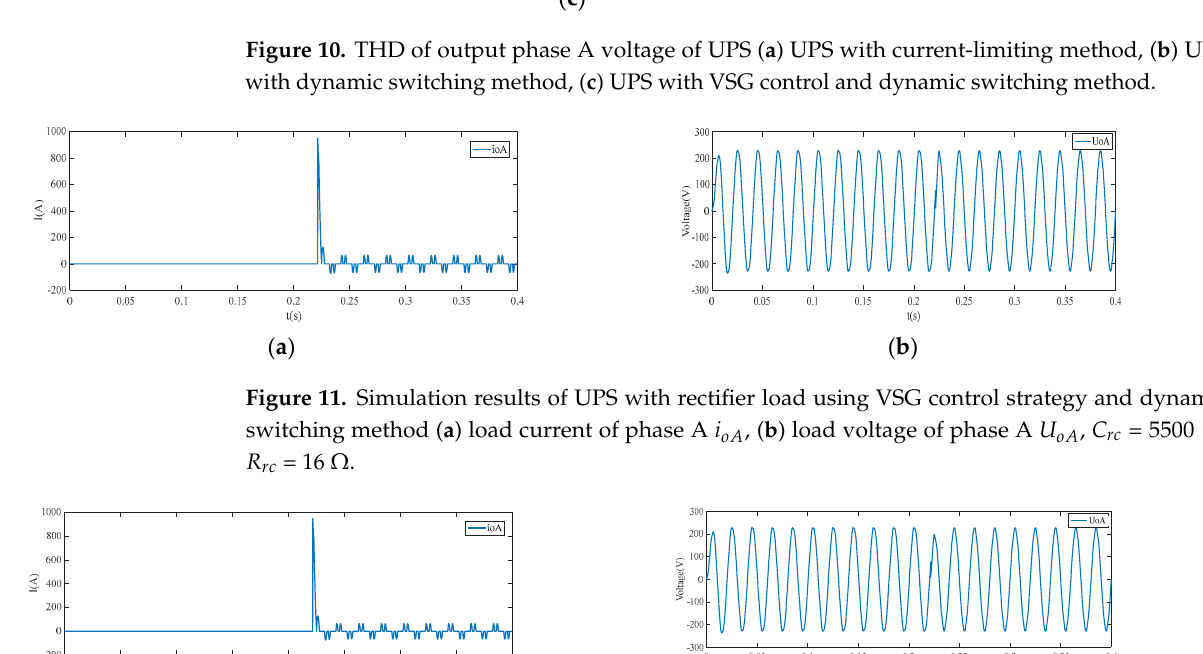
Figure 10. THD of output phase A voltage of UPS ( a ) UPS with current-limiting method, ( b ) UPS with dynamic switching method, ( c ) UPS with VSG control and dynamic switching method.